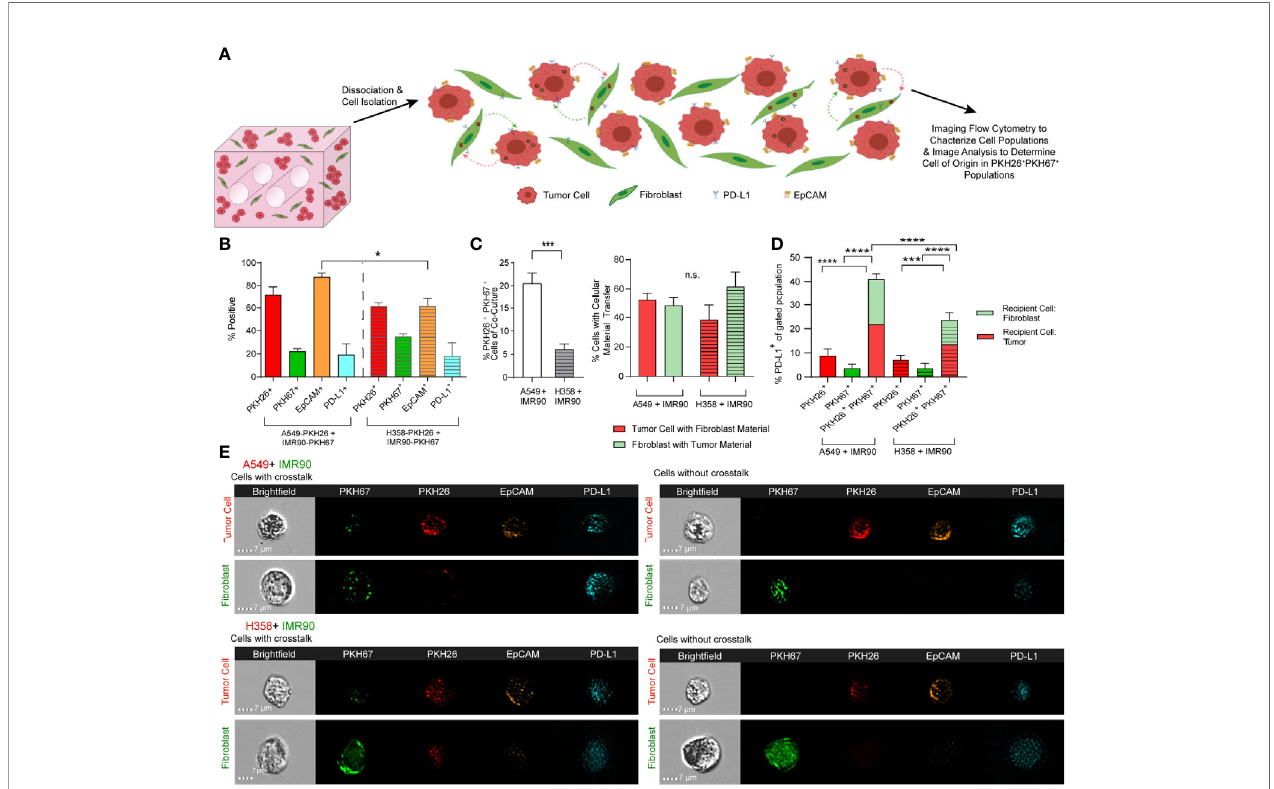
FIGURE 3 | Tumor-Stromal Crosstalk Occurs within Lung Cancer Mimics. (A) Cartoon representation detailing cell dissociation following co-culture and subsequent imaging fl ow cytometry to characterize cell populations and image analysis to determine the cell of origin in PKH26 + PKH67 + populations. (B) Characterization of models of both p53 null and p53 wild-type lung carcinoma shows variability in cell populations between models. (C) Increased tumor-stromal crosstalk, via internalization of cell material, is seen in the p53 wild-type model (left), but the percentage of tumor cells containing fi broblast derived EVs versus the percentage of fi broblasts that contain tumor cell derived EVs, or the double positive cell populations is similar (right). (D) PD-L1 expression is increased in cell populations with cell crosstalk via material transfer (PKH26 + PKH67 + ) when compared to cell populations without cell crosstalk (PKH26 + or PKH67 + ). (E) Representative Imagestrips showing cells with cell crosstalk, with transfer of fi broblast derived material (as shown by punctate PKH67 signal) to tumor cells (PKH26 labeled) or tumor cell derived material (as shown by punctate PKH26 signal) to fi broblasts (PKH67 labeled, left) compared to cells without crosstalk (right). n= 3 replicate bioreactors run in triplicate per experiment. ns, not signi fi cant, *p<0.05, ***p<0.001, ****p<